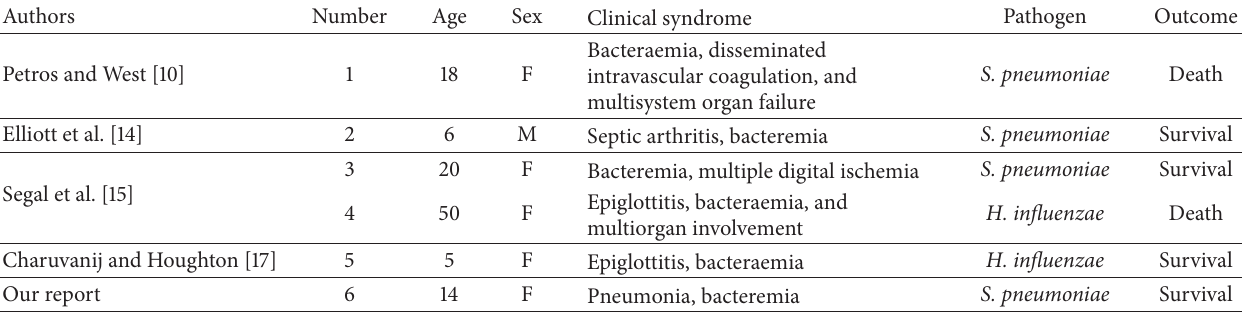
Table 1: Cases of systemic lupus erythematosus presenting with an acute bacterial